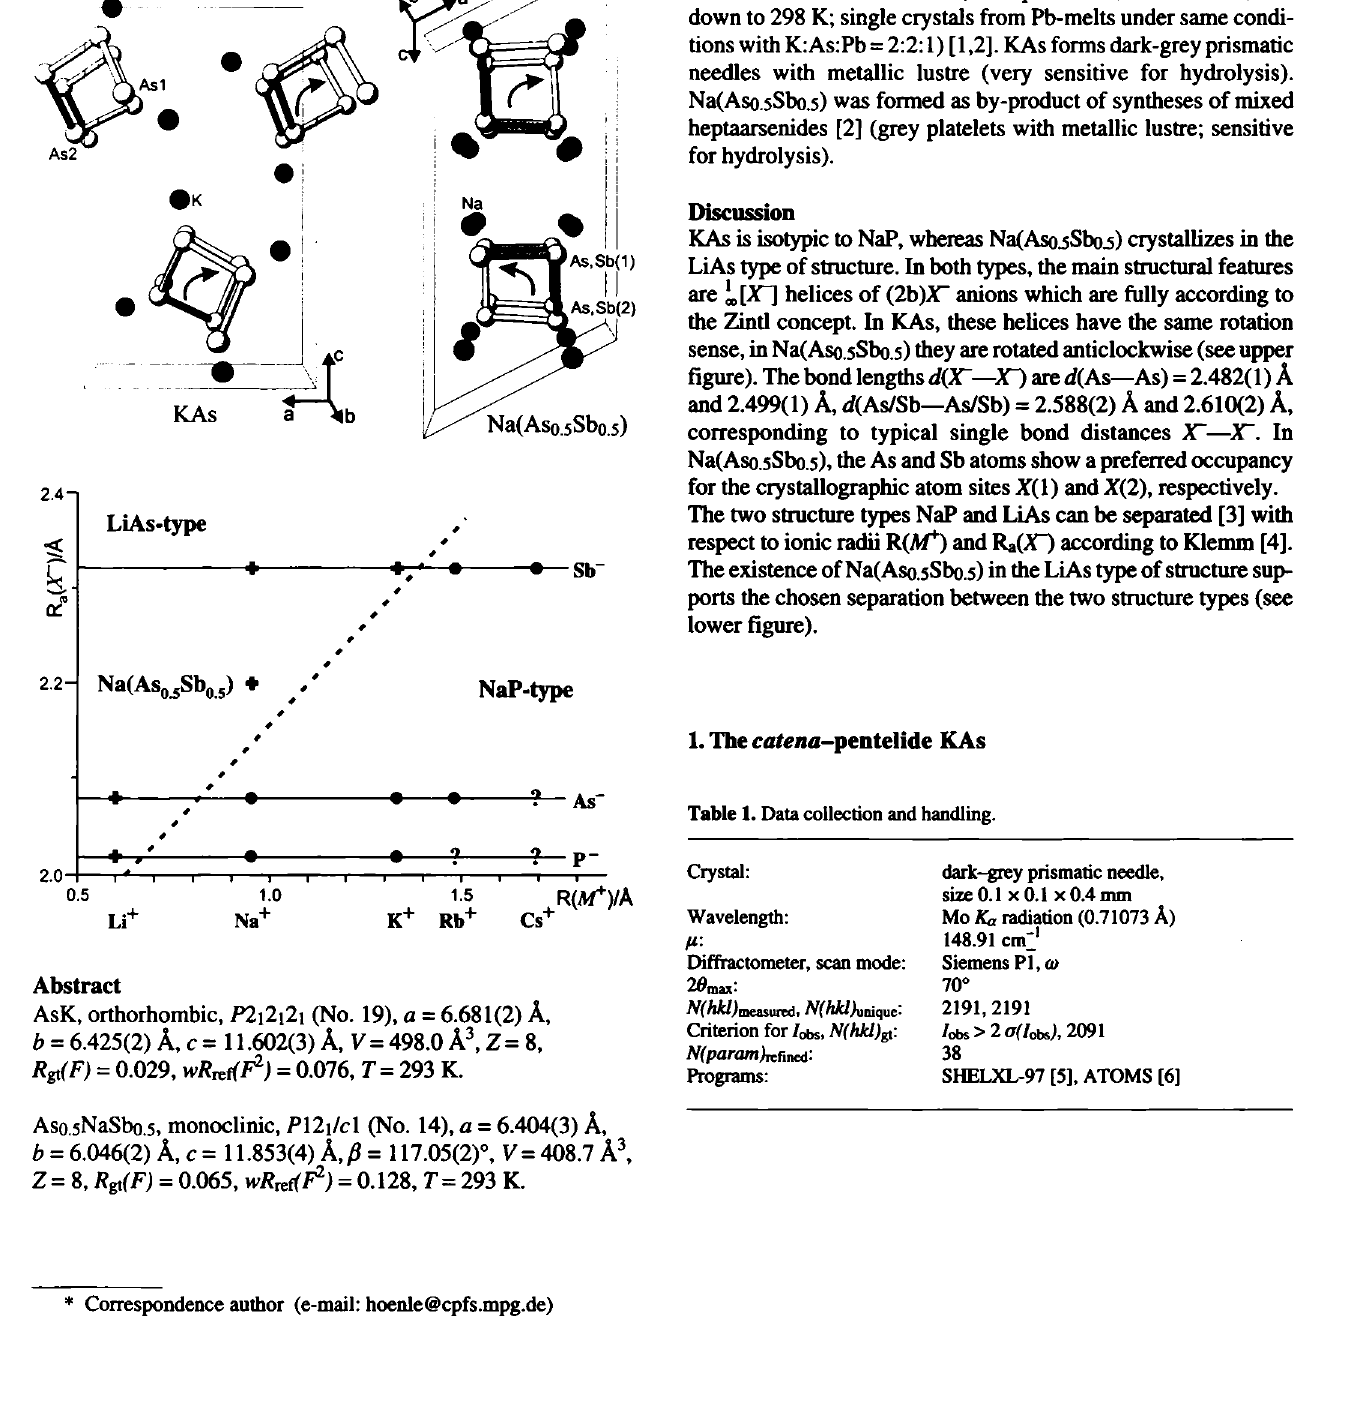
AsK, orthorhombic, P2\2\2\ (No. 19), a = 6.681(2) Â, b = 6.425(2) Â, c = 11.602(3) Â, V = 498.0 Â 3 , Ζ = 8, R (F) = 0.029, wRretfF 2 ) = 0.076, T= 293 K. & Aso .5NaSbo.5, monoclinic, P12i/cl (No. 14), a = 6.404(3) Â, b = 6.046(2) Â, c = 11.853(4) k,ß= 117.05(2)°, V= 408.7 Â 3 , Z= 8, Rgt(F) = 0.065, wRrtfiF 2 ) = 0.128, Τ =293 Κ.